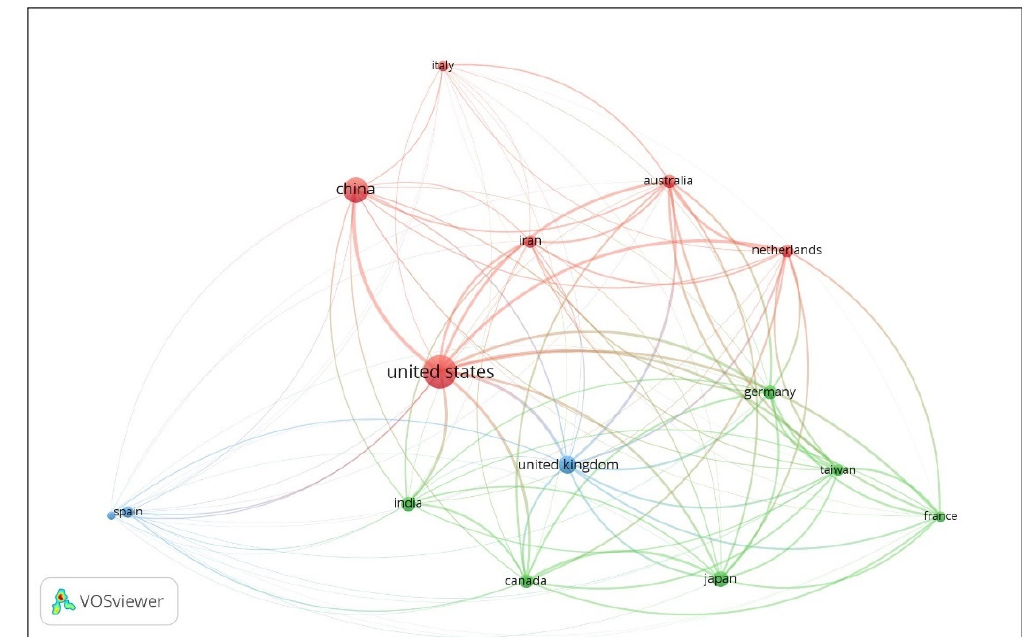
Figure 12. Bibliographic coupling by countries.